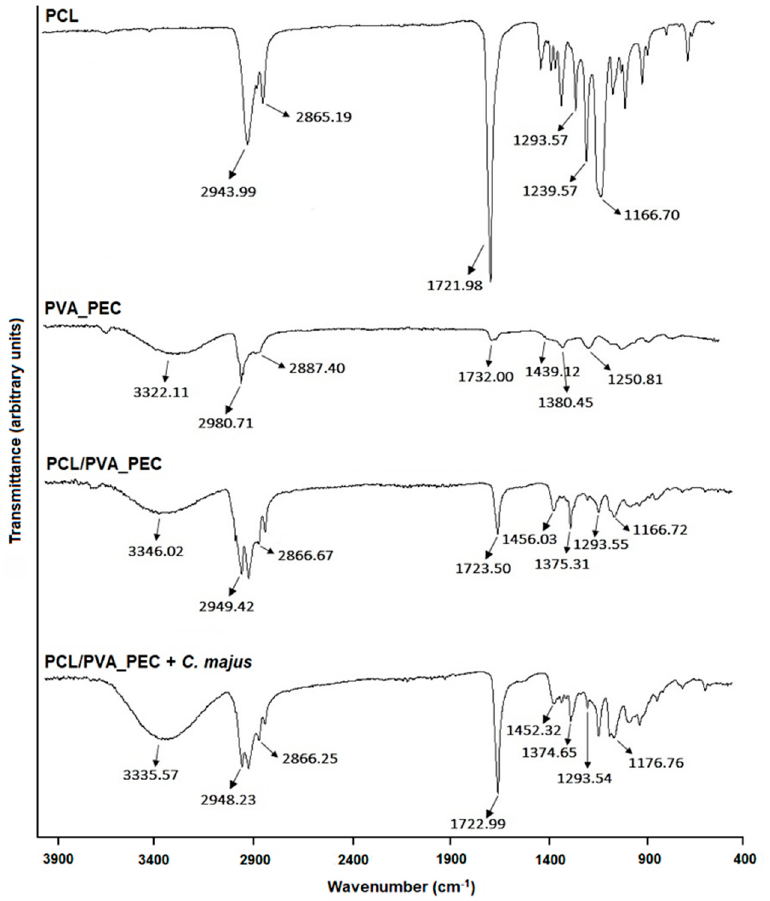
Figure 1. Attenuated total reflection-Fourier transform infrared (ATR-FTIR) spectra of PCL, PVA_PEC, and both the plain and the C. majus -loaded electrospun PCL/PVA_PEC nanofibrous meshes.